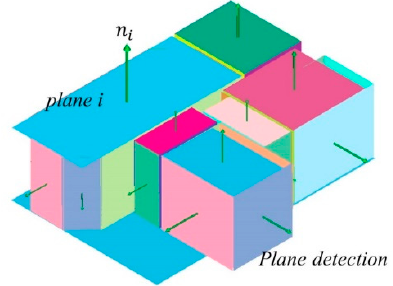
Figure 5. Detected planes from the mesh and colored in different colors.